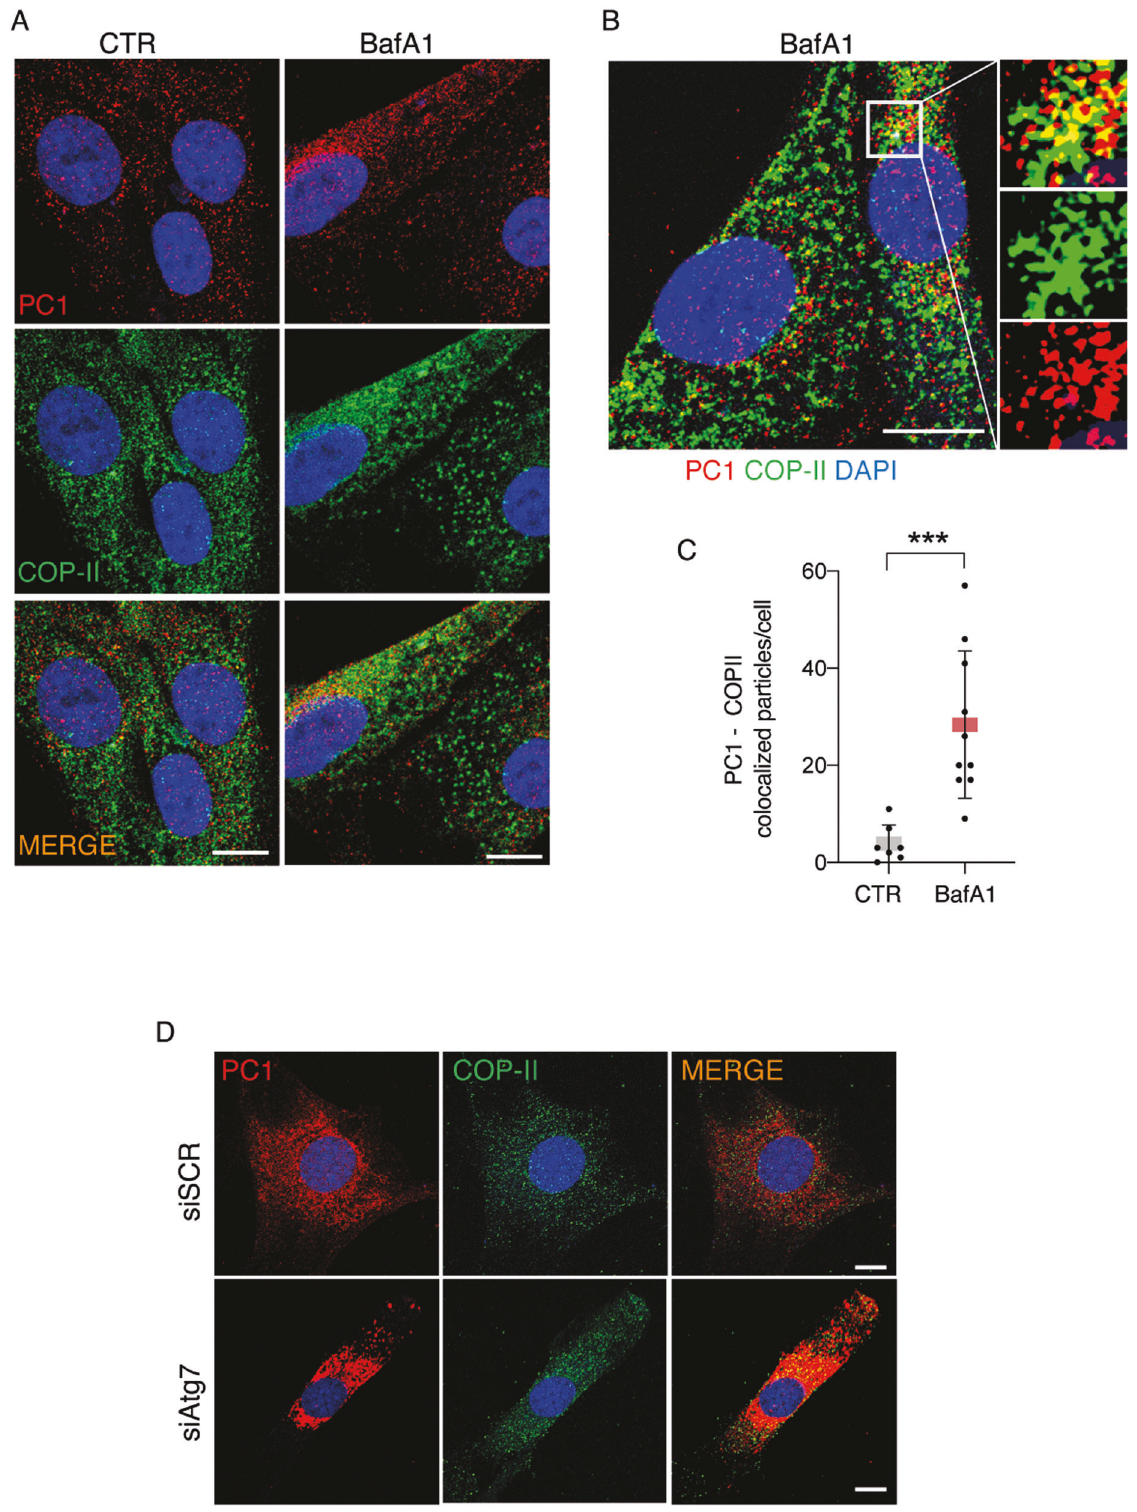
Fig. 3 Inhibition of autophagy results in accumulation of PC1 in the ER exit sites in primary human tendon cells. A Human tendon cells control and treated with BafA1 for 16 h were immunolabeled for PC1 (red), COPII (green), and nuclei stained with DAPI (blue) and analyzed by confocal microscopy. Scale bar = 10 μ m. B Cells treated with BafA1 for 16 h were immunolabeled for PC1 (red), COP-II (green), and nuclei stained with DAPI (blue) and analyzed by confocal microscopy. The insets show higher magni fi cation and single color channels of the boxed area. Scale bars = 10 μ m. C Quanti fi cation of PC1-COP-II colocalized particles per cell. *** p < 0.001, unpaired t -test. D Confocal microscopy images of control and siAtg7-treated cells immunolabeled for PC1 (red), COP-II (green), nuclei stained with DAPI (blue). Scale bar = 10 μ